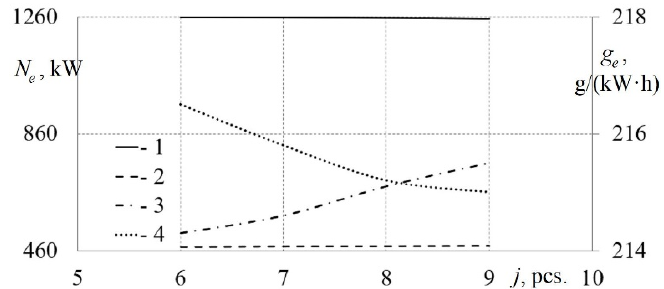
Figure 3. Dependences of power N e and specific fuel consumption g e on the number of holes j in the nozzle of the diesel injector at different modes: 1— N e = f ( j ) at the nominal engine mode; 2— N e = f ( j ) at idle; 3— g e = f ( j ) at nominal mode; 4— g e = f ( j ) at idle.